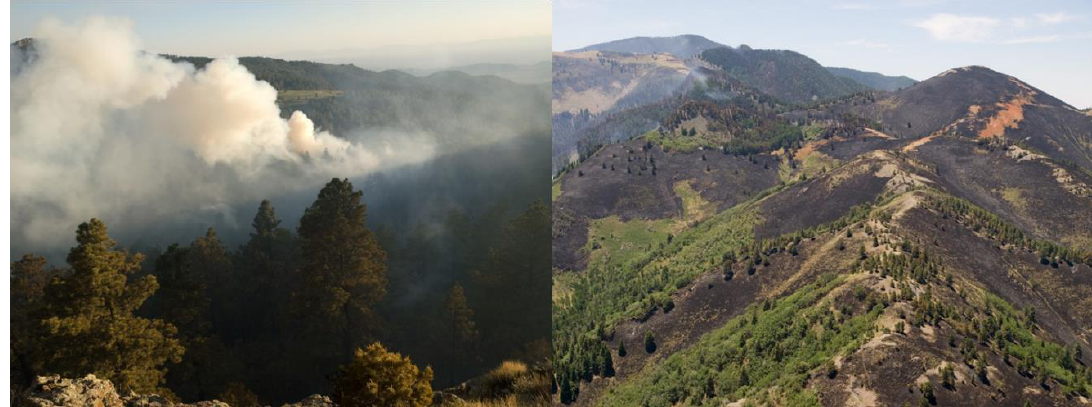
Figure 12. ( Left ) Photograph of Little Bear fire on June 9 2012 (courtesy of Kari Greer, United States Forest Service. ( Right ) Photograph of the burned area.